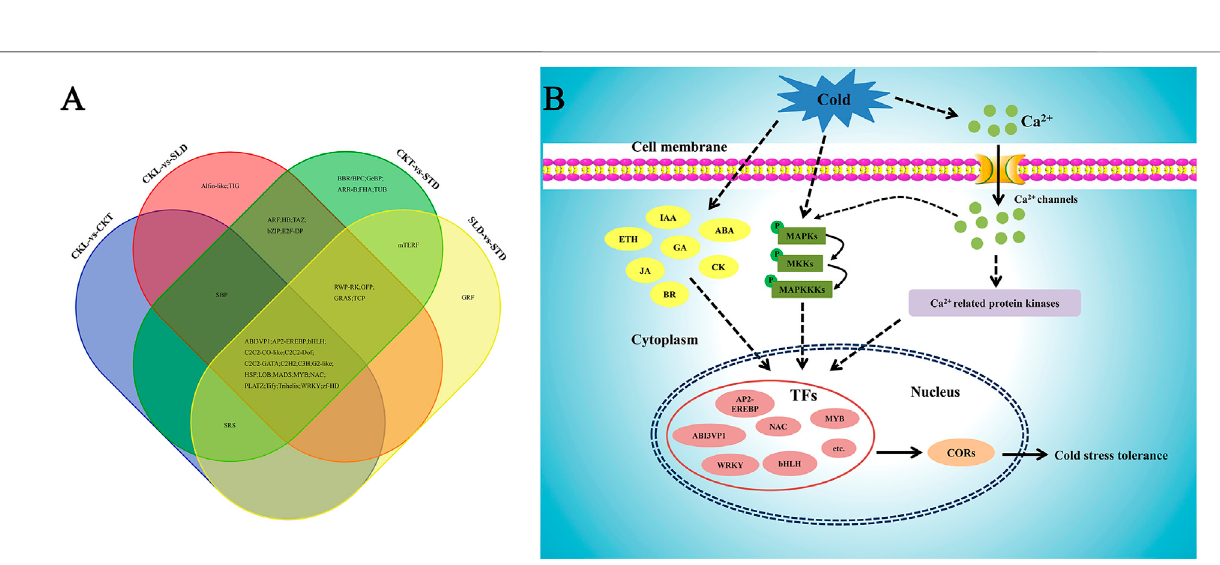
FIGURE 7 | MPK3/6 Are Activated by freezing Treatments. 14-day-old NA (A) and CA (B) seedlings were treated at -4 and -8 ° C for 3 h. Total proteins were extracted and immunoblotting assays were performed using anti-pTEpY. The gel stained with Coomassie brilliant blue was used as a loading control.